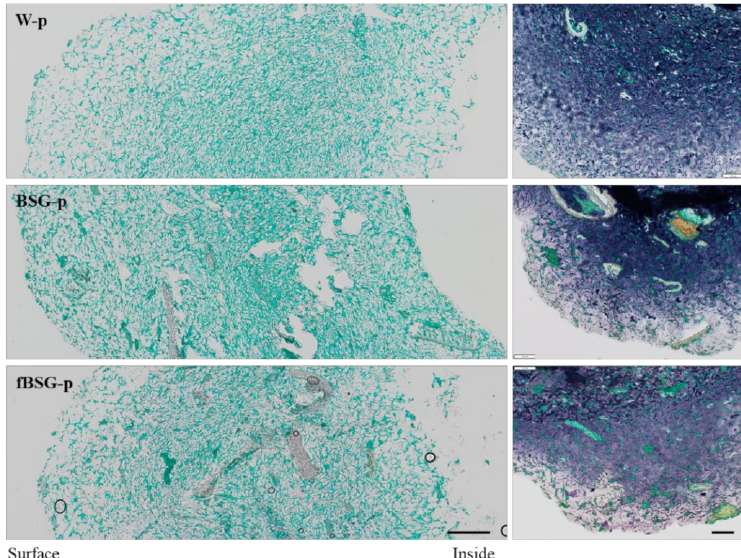
Figure 2. Brightfield microscopy analysis of pasta containing fermented and native brewers’ spent grain: BSG-p, pasta containing native brewers’ spent grain (15% wt/wt in replacement of semolina); fBSG-p, pasta containing fermented brewers’ spent grain (15% wt/wt in replacement of semolina); W-p, pasta made with durum wheat semolina. Proteins are shown in green and starch is shown in blue. Fibers are unstained. Scale bar left panel 200 µ m and right panel 100 µ m.